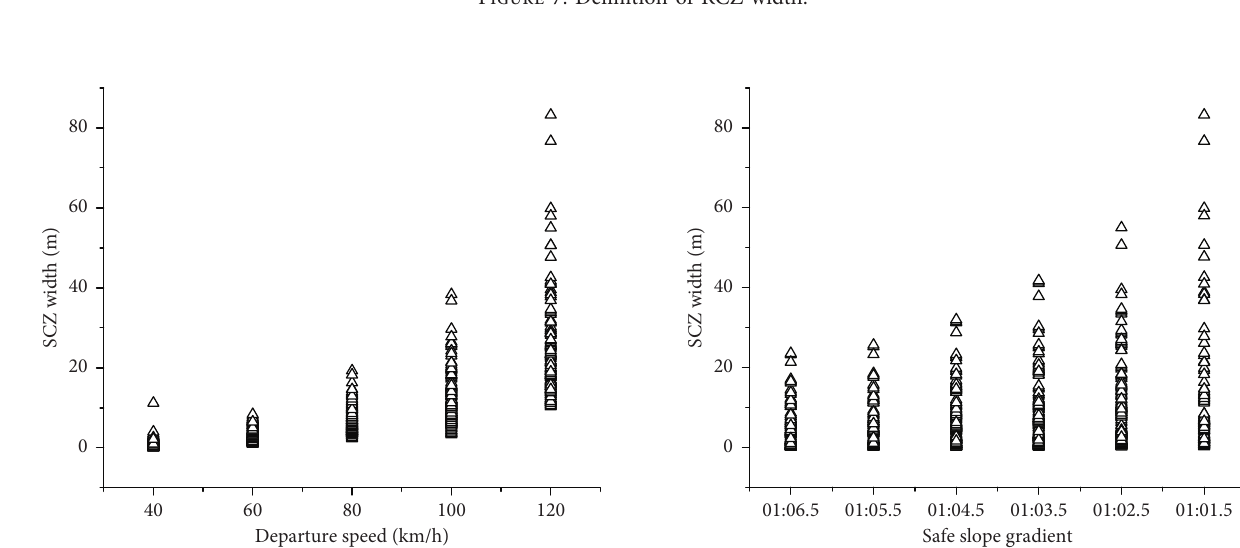
Figure 8: Relationship between l and the departure speed.